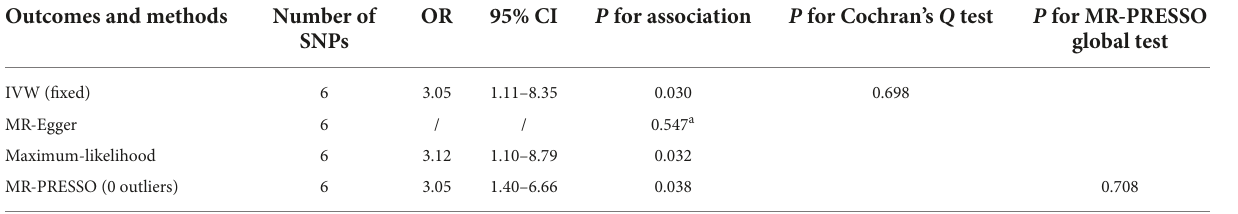
TABLE 2 A causal association between intake of beef and risk of rheumatoid arthritis (RA). Outcomes and